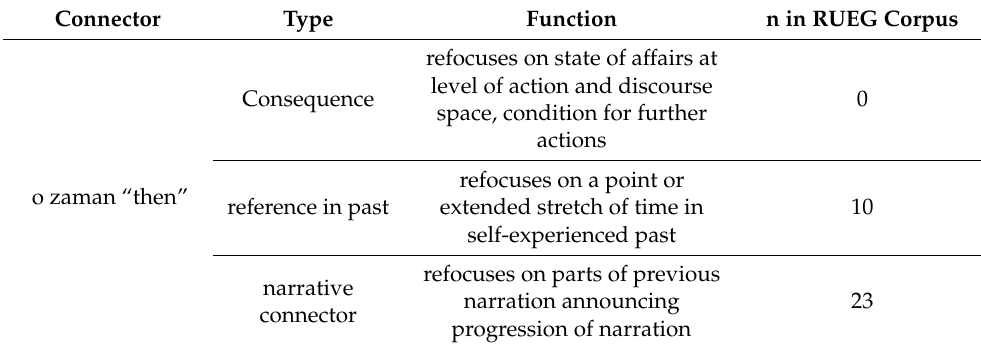
Table 5. Types and functions of o zaman in Turkish and uses in the RUEG corpus.